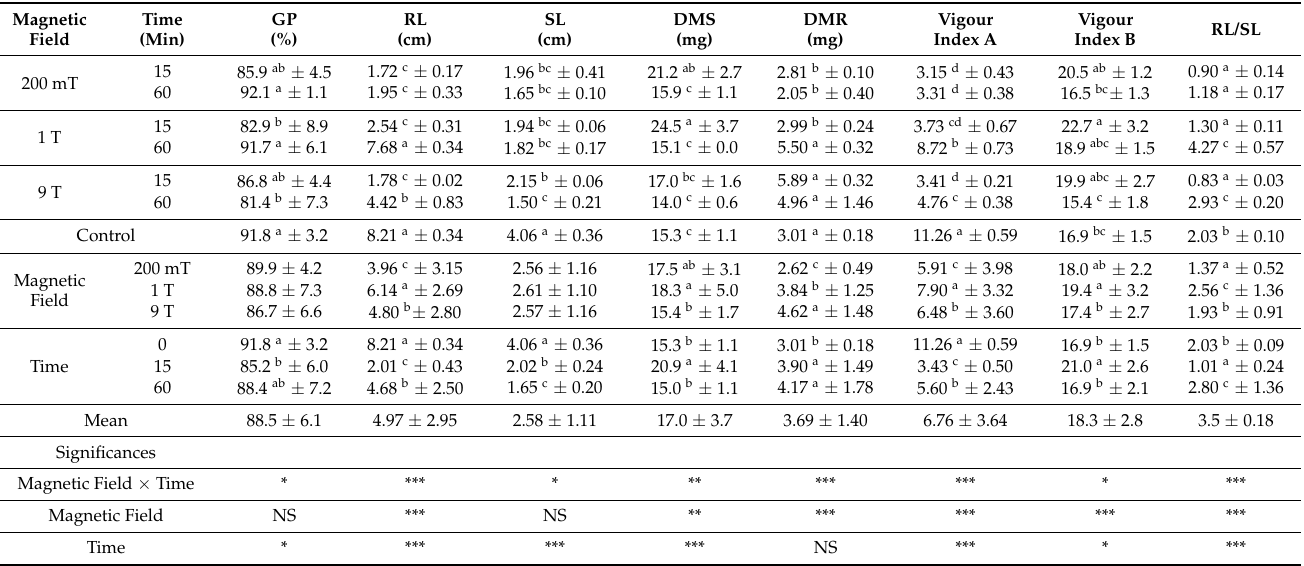
Table 2. Effects of Bitter magnetic field and seed exposure time on germination, selected seedling parameters, and vigour index values A and B (mean values for factors and interaction).